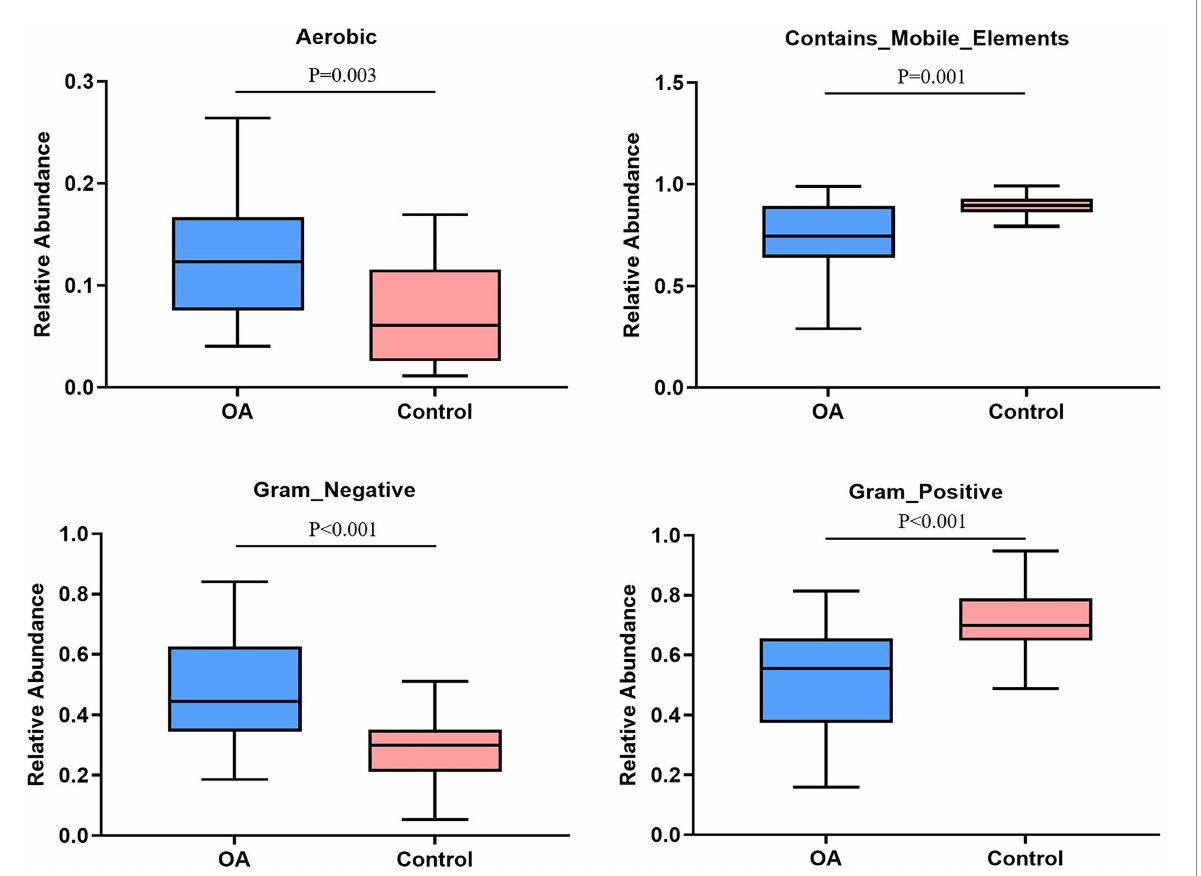
FIGURE 6 Phenotype analysis. The phenotypes with significant differences in relative abundance between groups. OA,